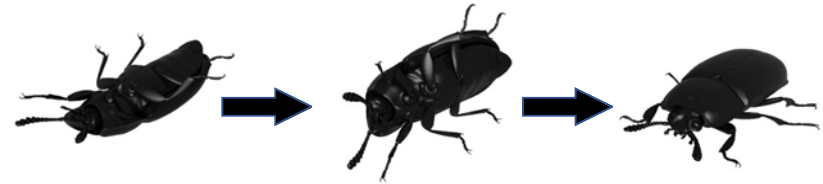
Figure 1. Schematic diagram of a crustacean’s self ‐ recovery method from a fall.